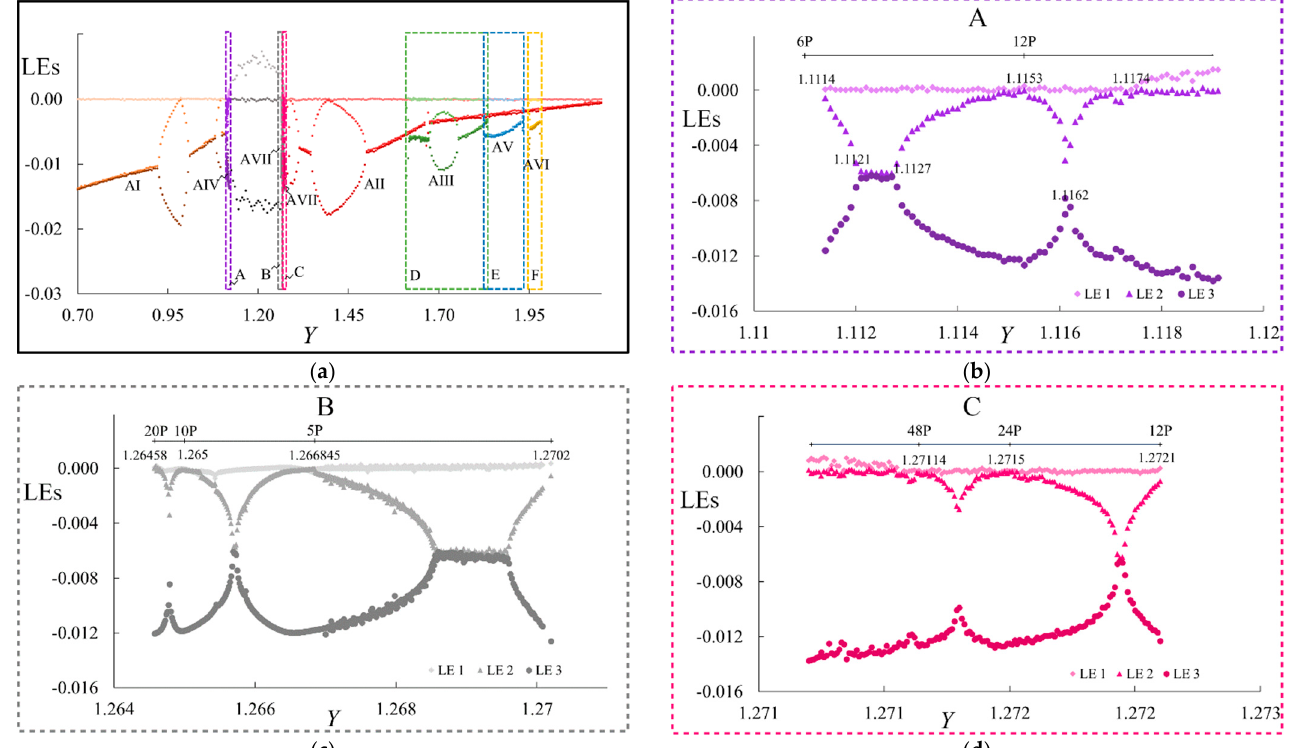
Figure 2. ( a ) Global view of 3 attractor domains using the first 3 LEs as a function of the injected field Y , AII coexists with AIII, AV, and AVI (domains D, E, and F respectively); Chaos coexists with AVII and AVIII (domains B and C, respectively); and AI coexists with AIV (domain A). ( b ) is AIV, ( c ) is AVII, and ( d ) is AVIII.